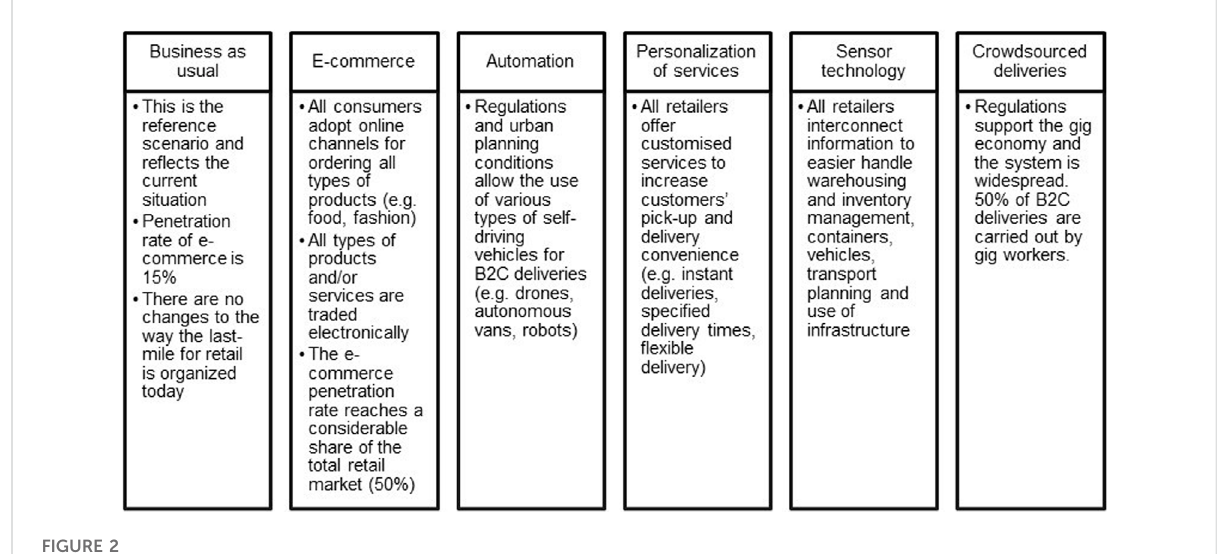
FIGURE 2 The MAMCA scenarios (Verlinde,